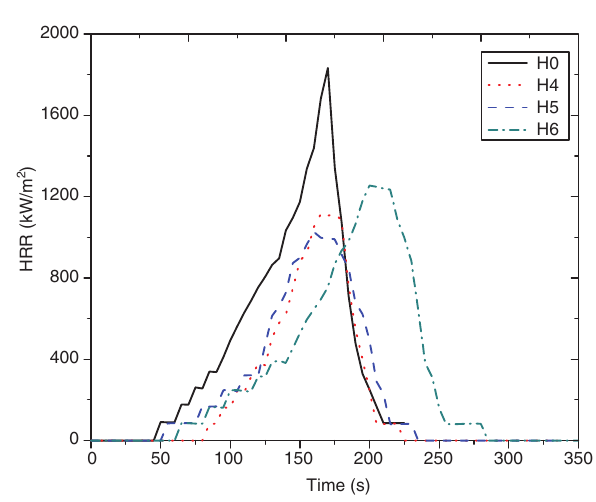
Figure 7: Heat release rate curves of neat PP (H0) and the PP/m. Ni-LDH nanocomposites.